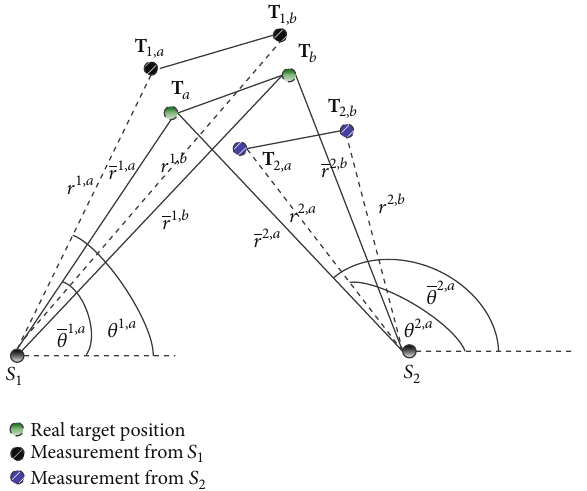
Figure 1: Sensor configuration